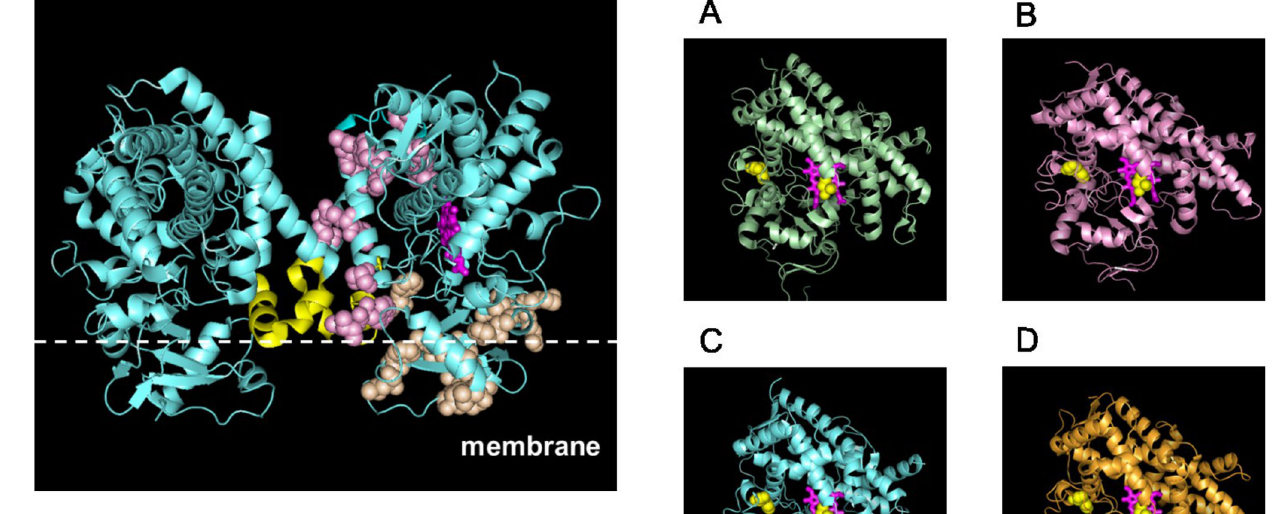
Figure 4. Functional networks of CYP2C9. Dimerization and membrane-binding networks were mapped on the crystal structure model of a CYP2C9 dimer (PDB code 1R9O). The dimerization network is shown in pink, the membrane-binding network is shown in orange, and the heme group is shown in magenta on the right monomer. The F-G loop is shown in yellow. The position of the membrane line was qualitatively positioned based on the location of the residues in the membrane-binding networks.